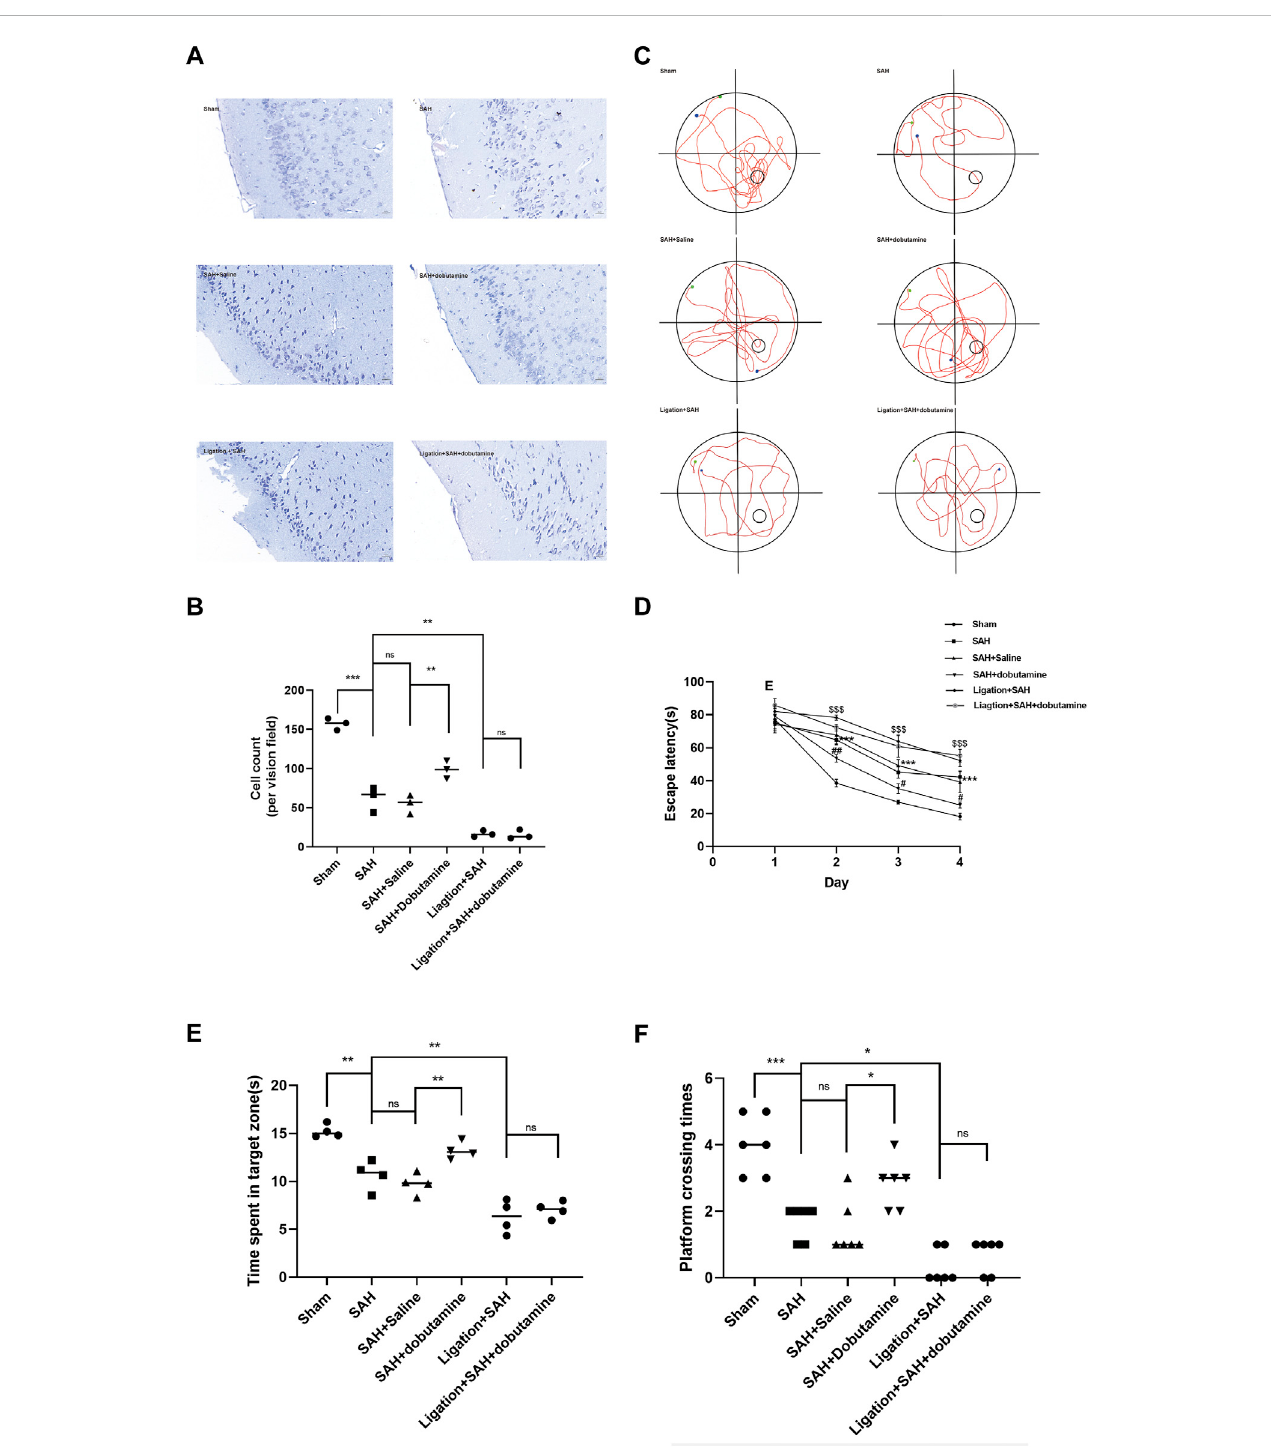
FIGURE 7 Dobutamine alleviated neuronal damage and improved cognitive function after SAH. (A) Representative Nissl staining of the dobutamine-treated SAH model. (B) Quantitative analysis of the morphologically normal neuron count. Data are presented as the mean ± SD ( n = 3 mice, * p < 0.05, and *** p < 0.001). (C) Representative swimming tracks of mice in the Morris water maze test. The green point indicates the starting point, and the blue point indicates the end point.Thesmallcircleinthelowerrightquadrantshowsthehiddenplatform. (D) Escapelatenciesinthe fi rst4dayswererecorded.Dataarepresentedas the mean ± SD ( n = 4 mice, *** p < 0.001 when the SAH + saline group was compared to the sham group, # p < 0.05 when the SAH + dobutamine group was compared to the SAH + saline group, ## p < 0.01 when the SAH + dobutamine group was compared to the SAH + saline group, and $$$ p < 0.001 when